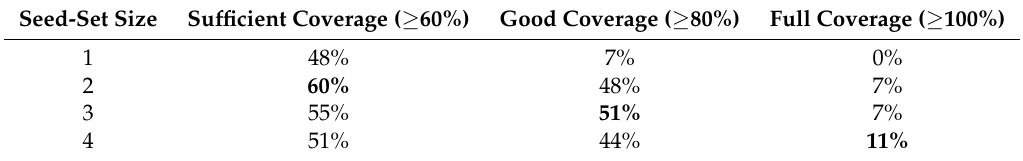
Table 10. % of semantic fields which reach sufficient, good or full coverage by seed